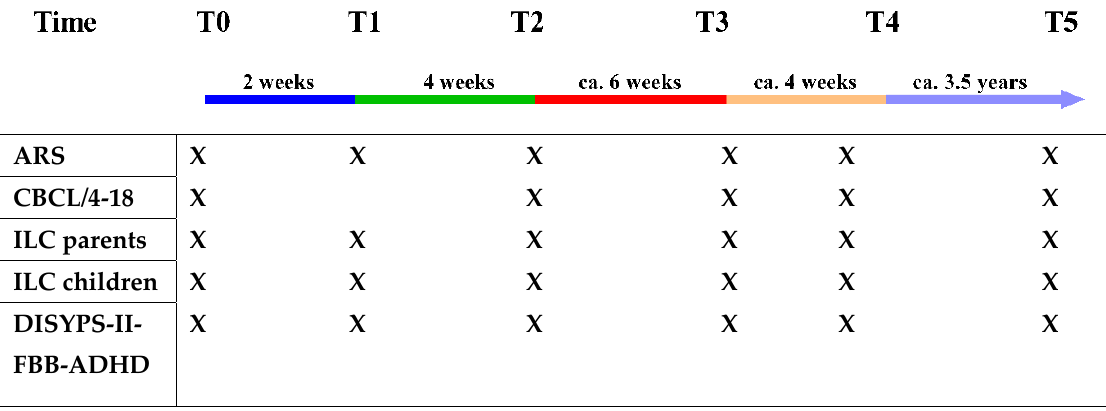
Figure 1. Timescales and measures for each appointment. Blue line: pre-diet phase; green line: diet phase OD; red line: reintroduction, testing the different main food groups, orange line: reconfirm different food intolerances, purple line: follow-up.